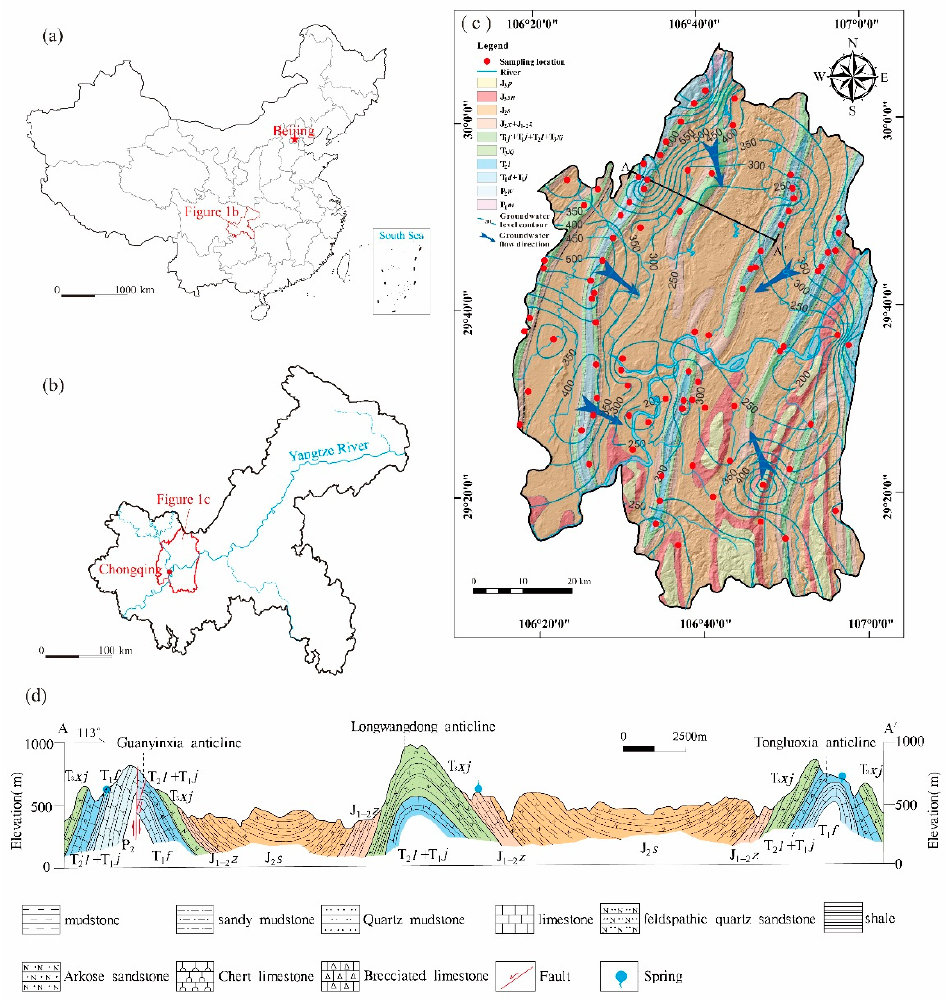
Figure 1. ( a ) Location of Chongqing in China, ( b ) Location of the main urban area in Chongqing, ( c ) General geology and shaded relief map of the main urban area of Chongqing with groundwater sampling locations, ( d ) Geologic section of A-A’ showing alternative occurrence of anticlines and synclines within carbonate and clastic rocks.